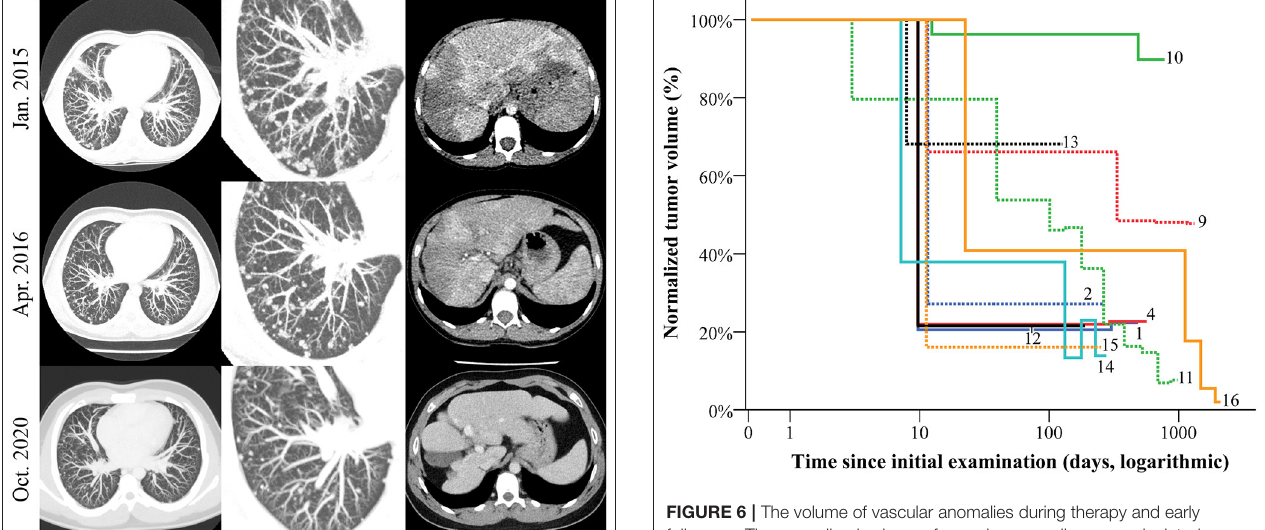
GLA (#7), already in PR, to accelerate the resolution of the pericardial effusion.